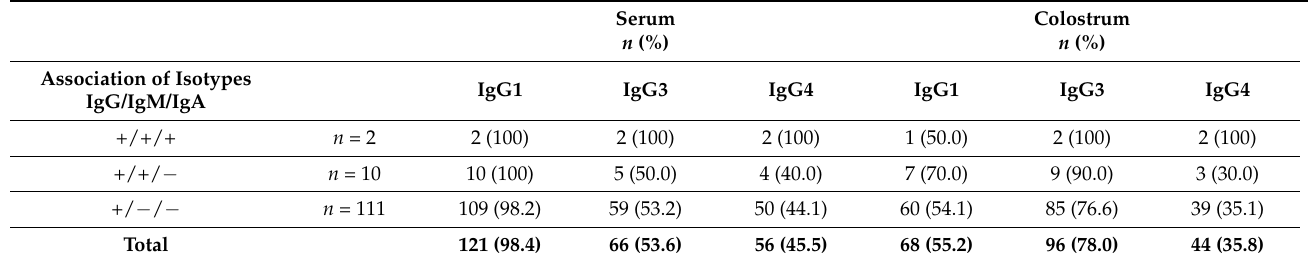
Table 1. Association among the levels of IgG1, IgG3, and IgG4 subclasses specific to T. gondii and IgG, IgM, and IgA isotypes in serum and colostrum samples from 123 puerperal women from Uberl â ndia, MG, Brazil. Data are presented in number ( n ) and percentage (%) of the analyzed samples. Serum Colostrum n (%) n